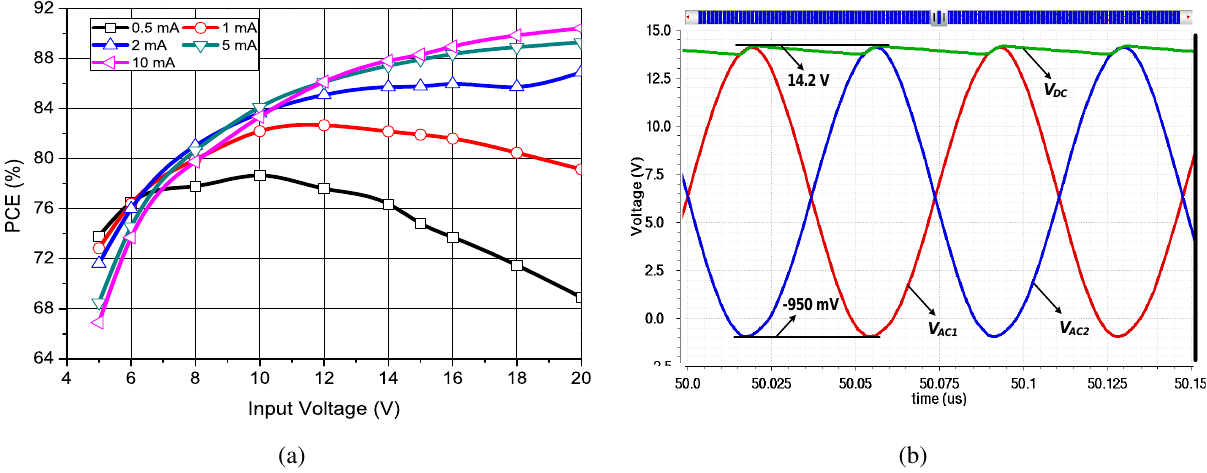
Figure 11. Simulated: ( a ) power conversion efficiency (PCE) with varying input voltage and load current; ( b ) transient response of the proposed rectifier.